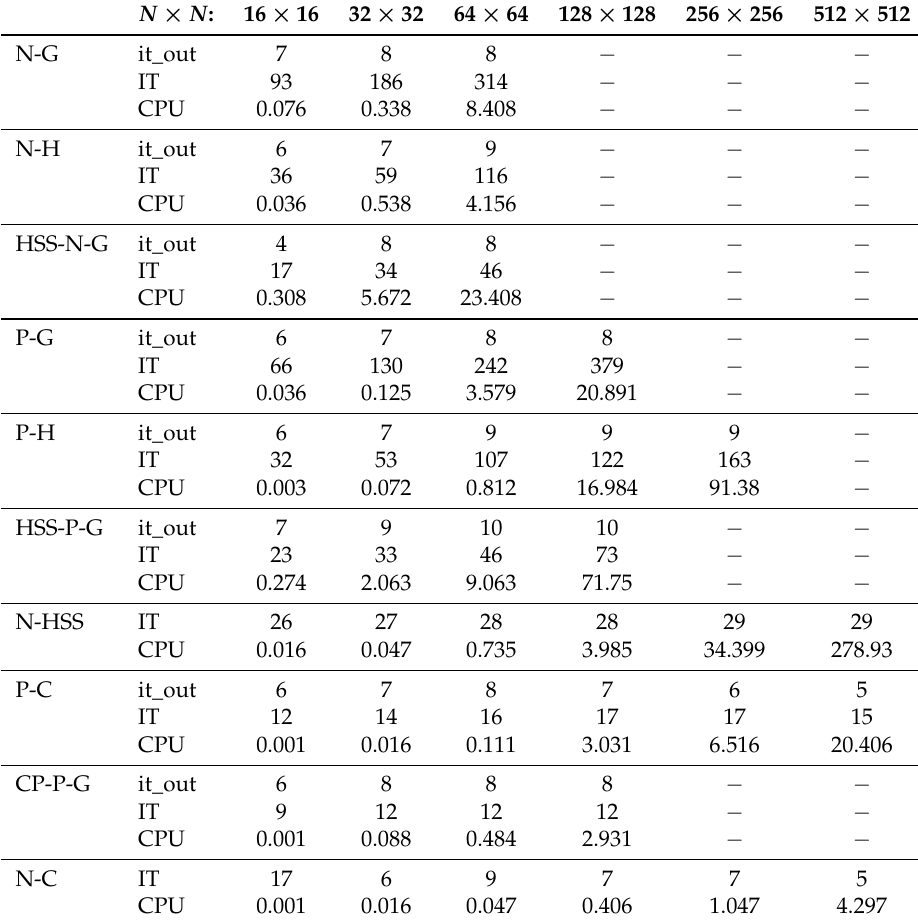
Table 7. Iteration counts and elapsed CPU time for Case 2.1 .